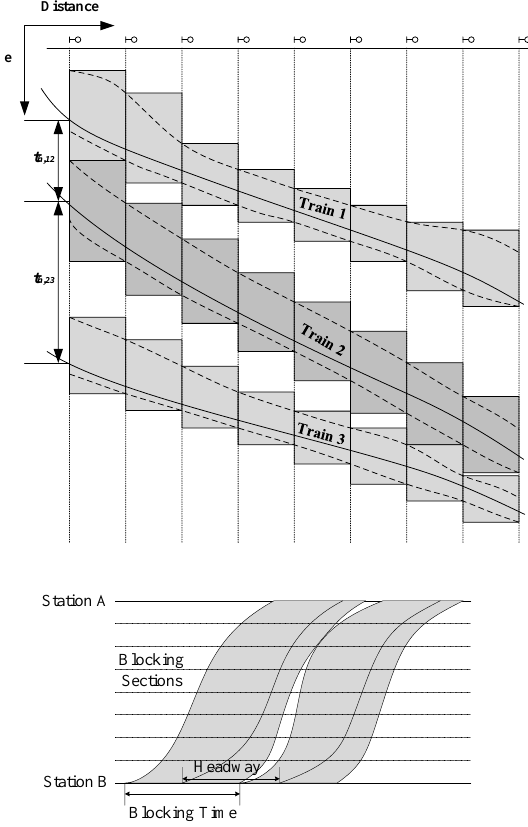
Figure 2. Diagram of the train headway proposed by Pachl.